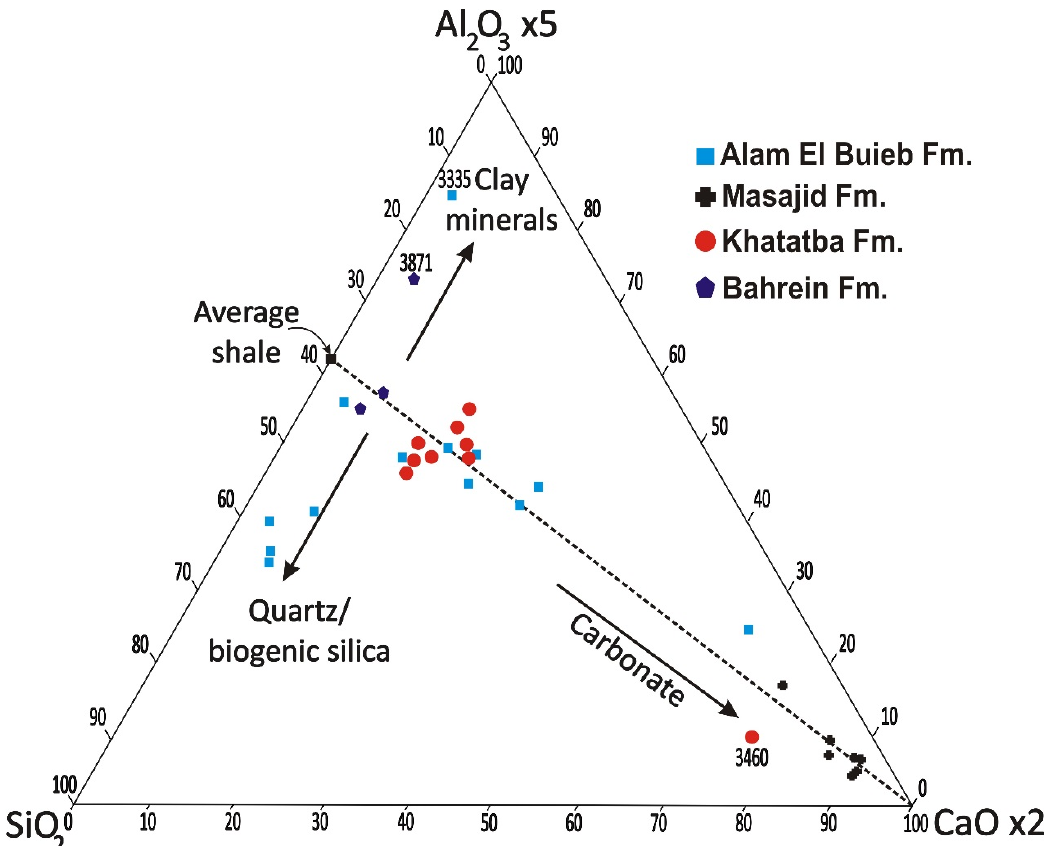
Figure 8. Geochemical ternary plot of SiO 2 -5*Al 2 O 3 -2*CaO to reveal variations in lithological differ- ences of the Jurassic–Lower Cretaceous sediments in the Almaz-1 well. Most samples scatter around the line of average shales and carbonates [25]. Four samples from the Alam El Bueib Formation showed enhanced contribution of quartz, while two samples from the Bahrein and Alam El Bueib formations were dominated by clay minerals.